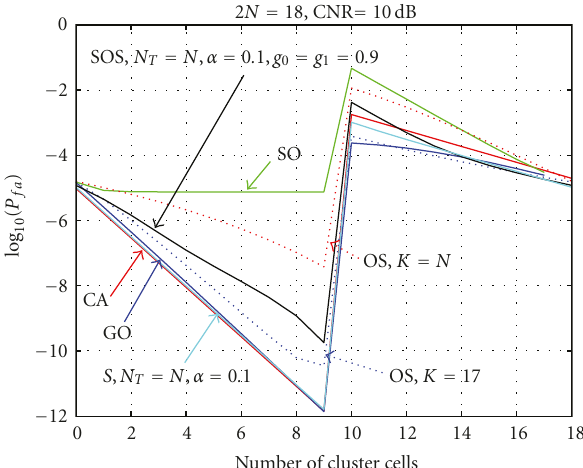
Figure 11: Comparison of P d of SOS I by CA, GO, SO, and OS ( k = N = 9, k = 15, and k = 17) in the case of three multiple targets (INR = 2SNR) for P fa = 10 − 5 and 2 N = 18.